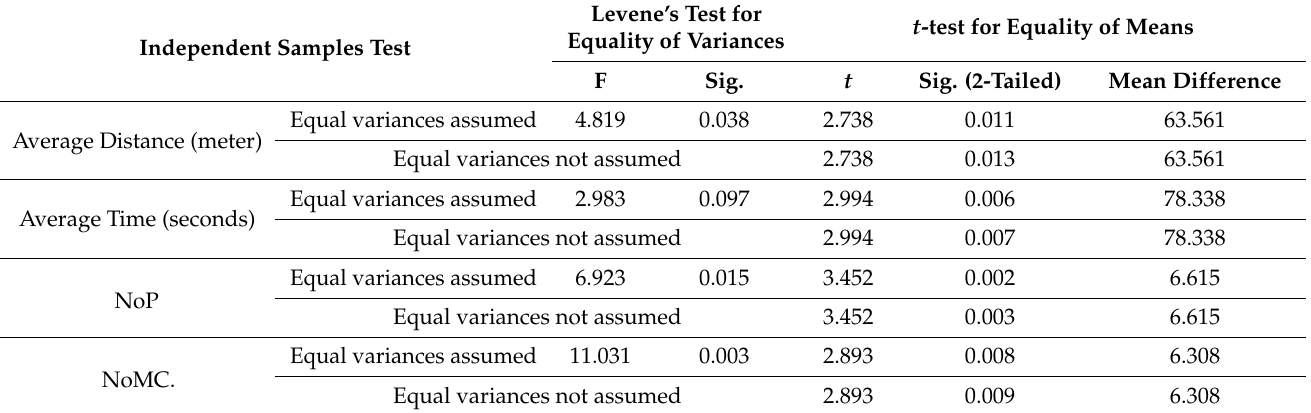
Table 4. t -test results for the two VREs.